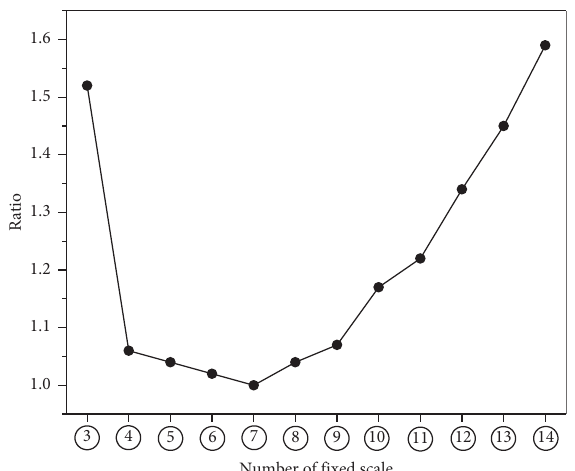
Figure 8: Te ratio of each fxed scale height to the minimum height of the fxed scale in the